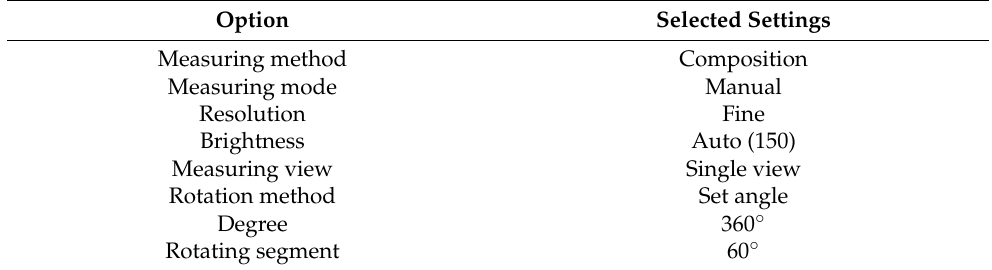
Table 2. Selected settings on the optical coordinate measuring system VL-550.